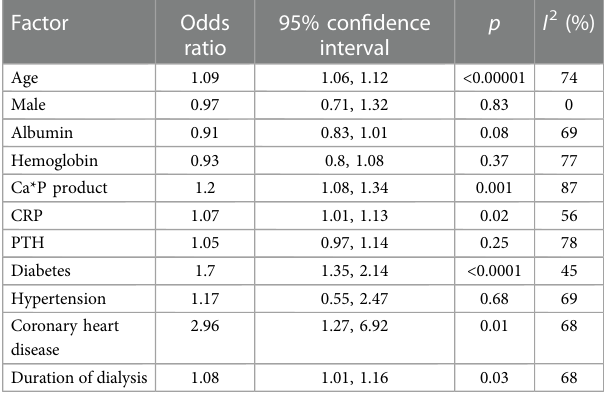
TABLE 2 Risk factors for CVC in patients with